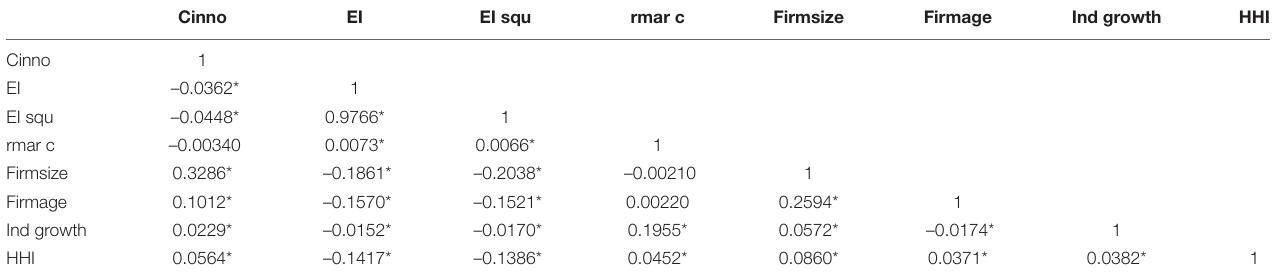
TABLE 1 | Table of correlation coefficients of variables. Cinno EI EI squ rmar c Firmsize Firmage Ind growth